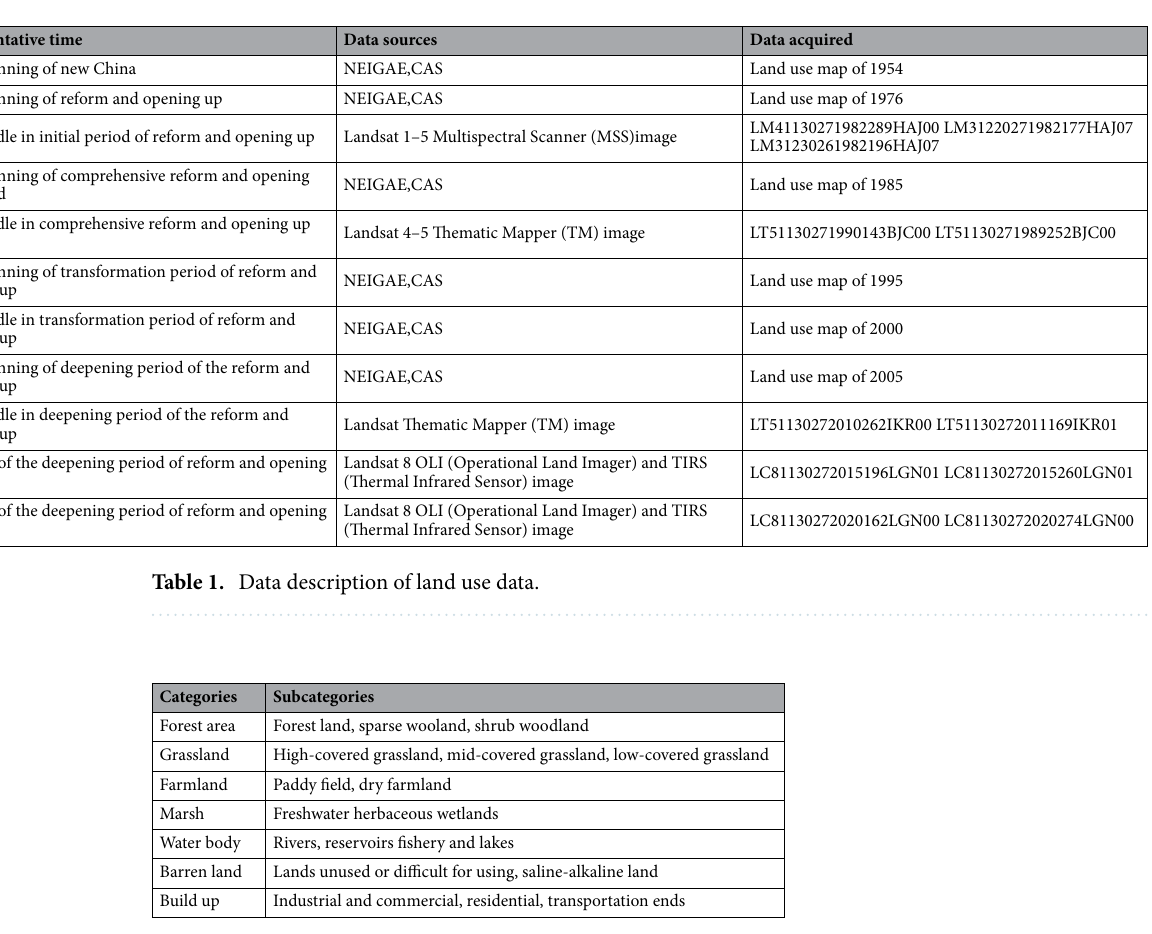
Table 2. Land cover types in 1:100,000 land use